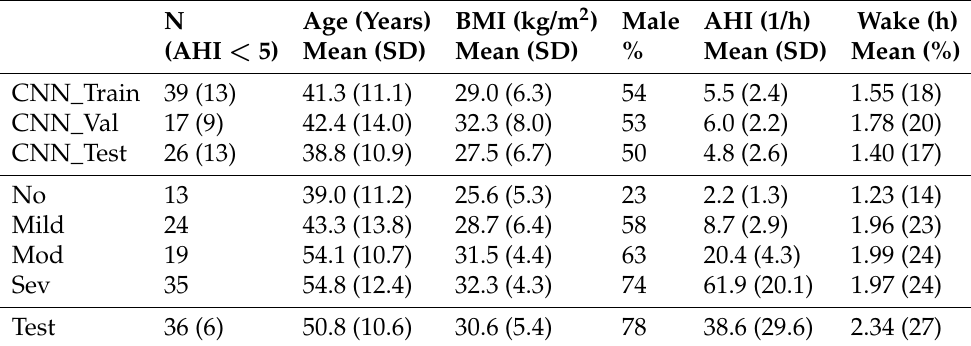
Table 1. Demographic and clinical information of the study datasets. N is the number of subjects in the dataset, with the number of non-apneic patients indicated between brackets. The column AHI indicates the average and SD of the AHI over all patients in the corresponding dataset. The last colum Wake indicates the time spent in wakefulness, averaged over all patients in the corresponding dataset. Within brackets, the percentage of wakefulness in the total recording is given. All datasets contained PSG recordings. The unseen dataset Test additionally contained ccECG and ccBioZ recordings.